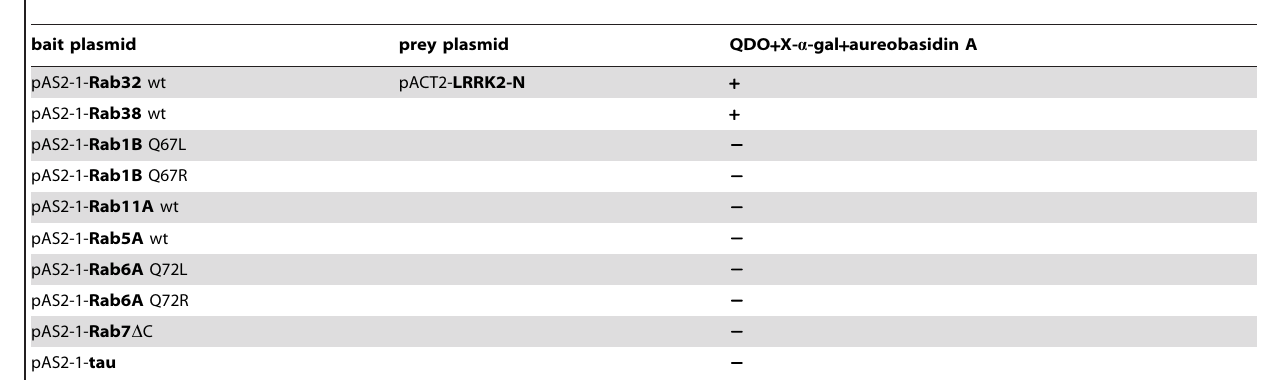
Table 1. Rab binding specificity of LRRK2-N.